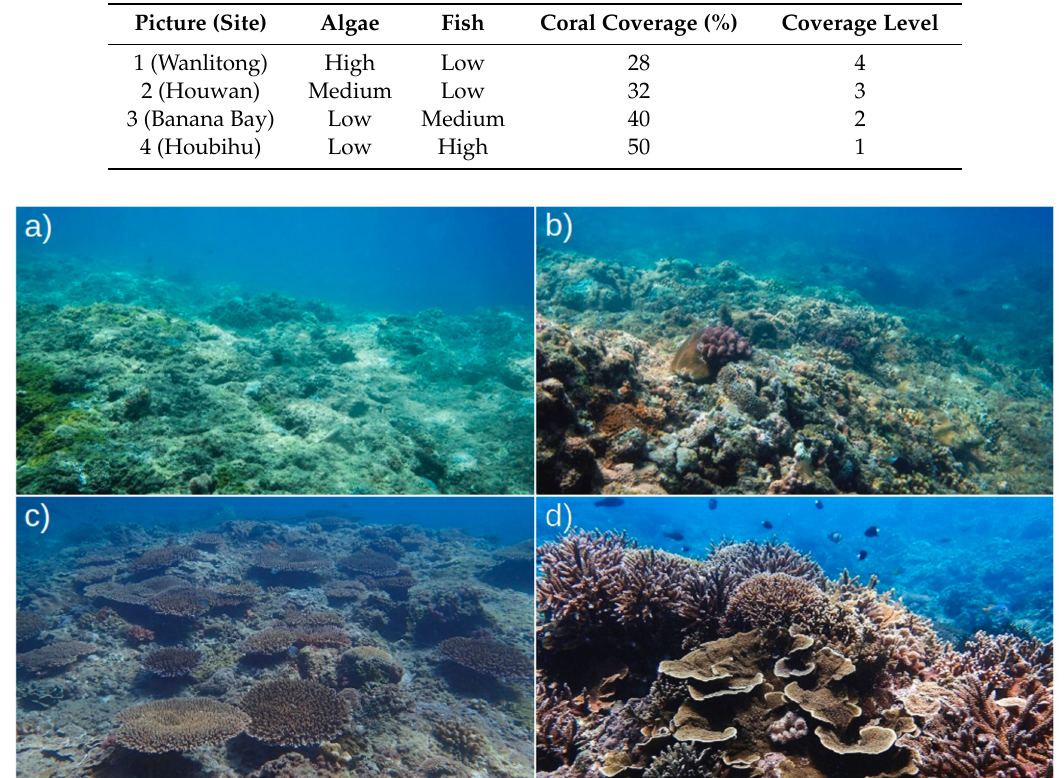
Table 1. Biological features of selected pictures.